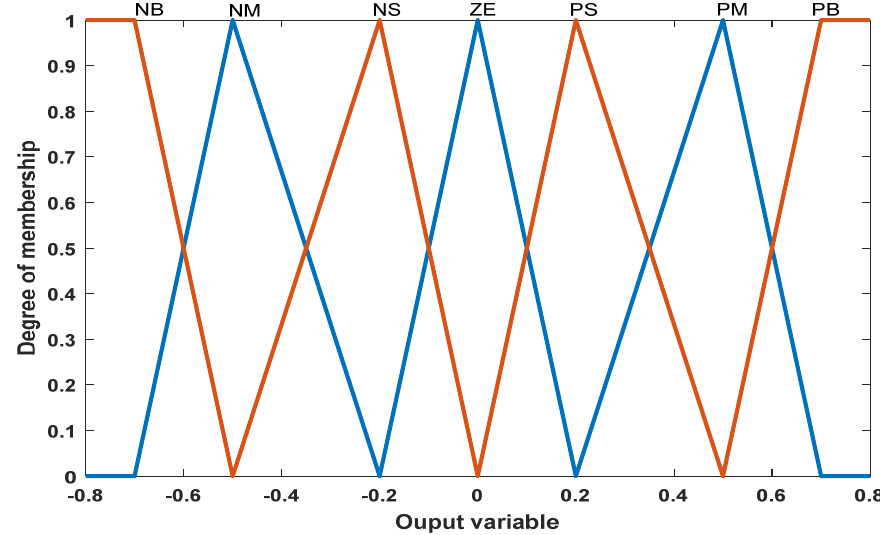
Figure 4. Output membership function. Table 1. Rule base for fuzzy controller [27,28].